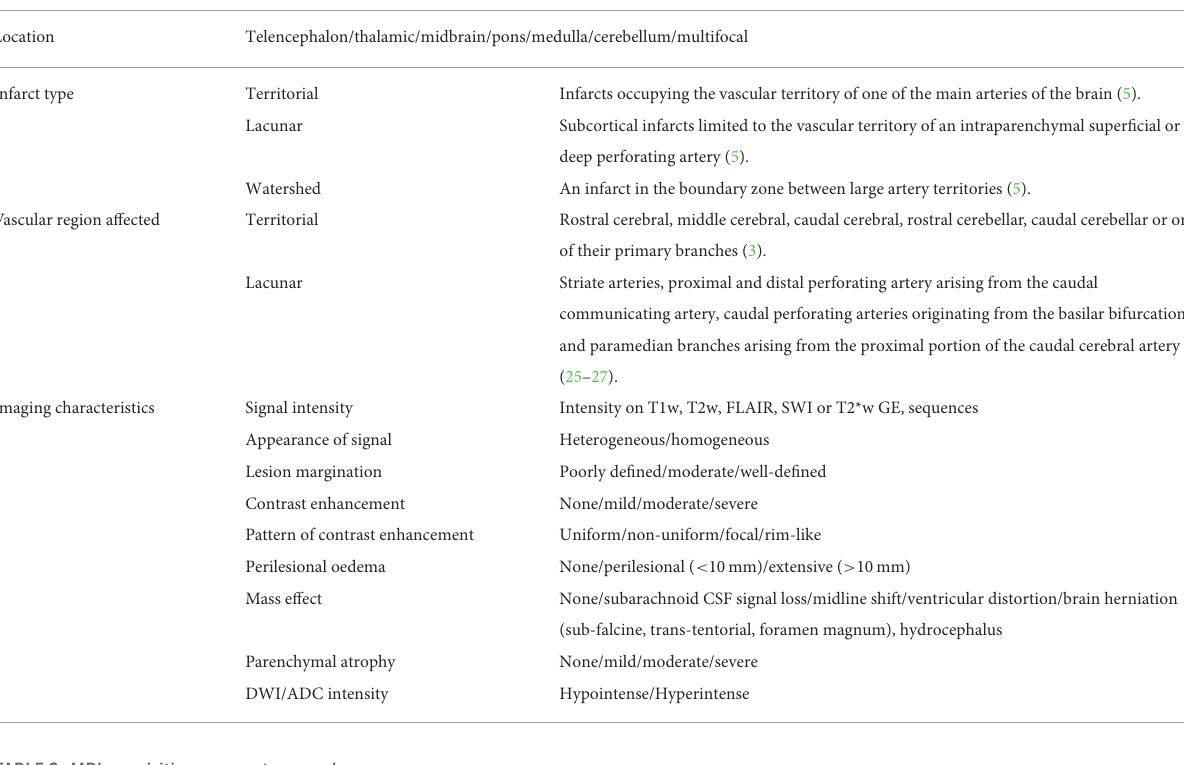
TABLE 1 Summary of imaging features recorded.